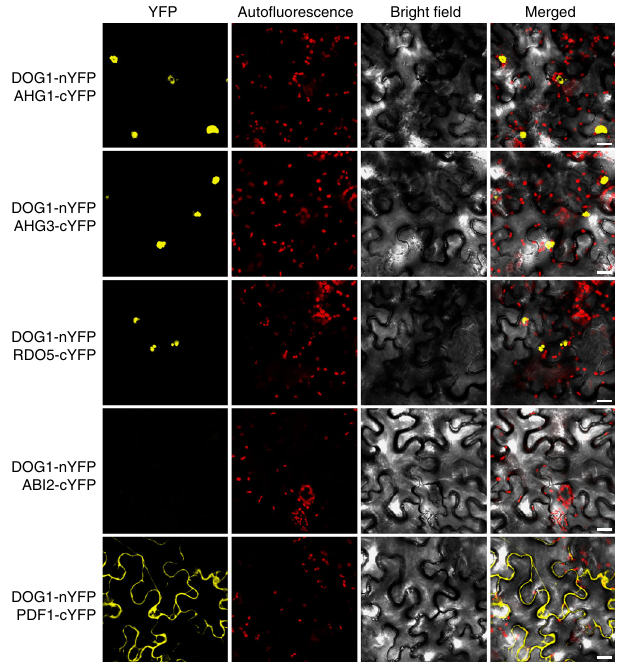
Fig. 3 Con fi rmation of interactions between DOG1 and phosphatases using BiFC. BiFC assays for interactions between DOG1 and phosphatases in Nicotiana benthamiana leaves. Leaves were co-agro-in fi ltrated with constructs expressing DOG1 fused to the N- and AHG1, AHG3, RDO5, ABI2 or PDF1 fused to the C-terminus half of YFP. AHG1, AHG3 and RDO5 show strong interaction with DOG1 in the nucleus. PDF1 interacts with DOG1 in the cytoplasm. The PP2C clade A phosphatase ABI2 that was not identi fi ed in pull-down assays from seeds does not show af fi nity for DOG1. The reconstructed YFP fl uorescence was recorded 48 h post agro- in fi ltration by confocal microscopy. Red signals indicate chloroplast auto fl uorescence. Scale bars, 20 μ